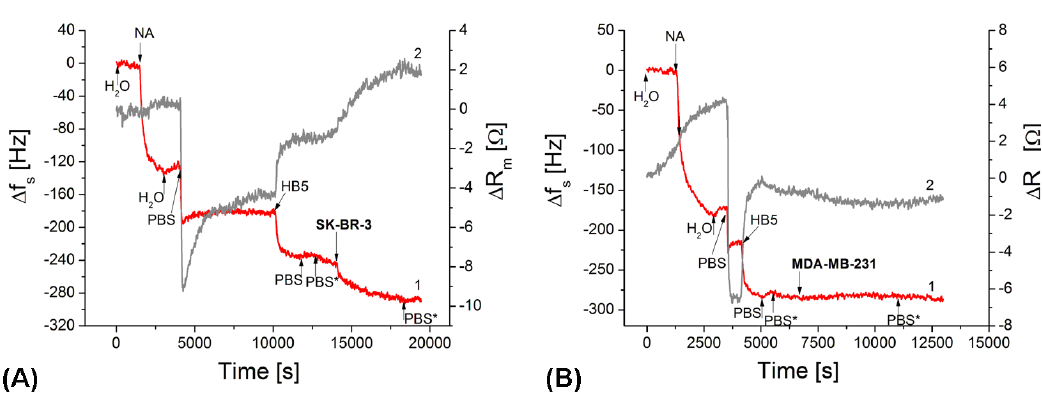
Figure 4. The kinetics changes of the series resonant frequency, ∆ f s , (curve 1) and motional resistance, Δ R m , (curve 2) of TSM transducer following addtion of NA (125 μ g/mL), HB5 aptamers (0,25 μ M) and SK-BR-3 cells ( A ) or MDA-MB-231 cells ( B ). The concentration of the cells was 5 × 10 4 cells / mL. The arrows indicate addition of respective compounds as well as washing of the surface by water, PBS and by PBS with addition of aliquote volume of DMEM (PBS*).